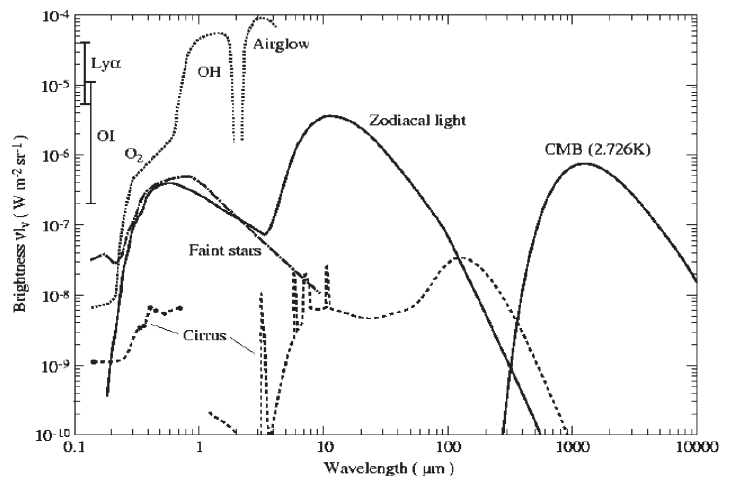
Figure 1. Overview of the various components of the total night sky background at high galactic and ecliptic latitudes. The Zodiacal Inter-Planetary Dust emission, Zodiacal scattered light, and starlight (bright stars excluded) are indicated. The interstellar Galactic (cirrus) emission is normalized to the minimum column density observed at high Galactic latitudes ( N H = 10 20 H atoms/cm 2 ). Atmospheric O 2 air glow and OH emissions in the near-IR, as well as the CMB, are also indicated. (Figure taken from Leinert et al.